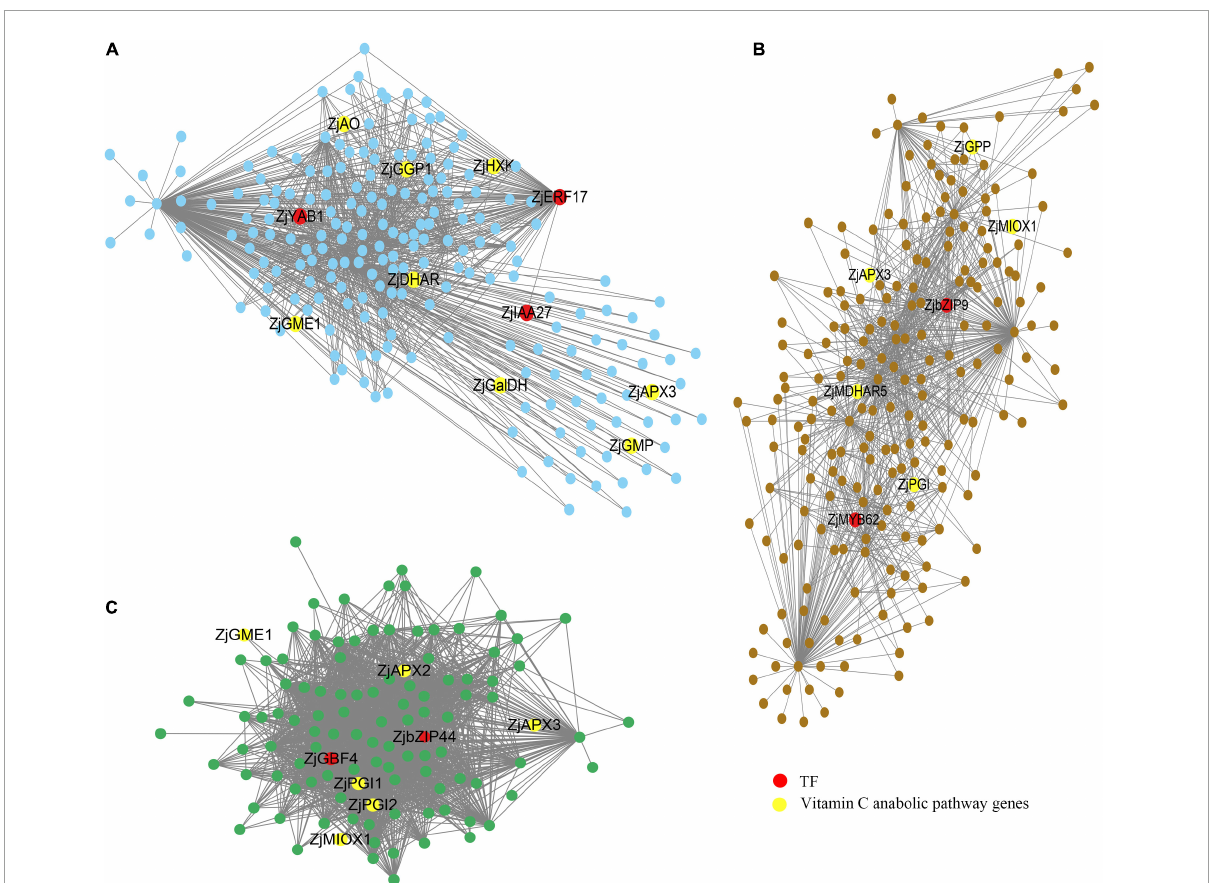
FIGURE6 Gene networks involved in AsA regulation during jujube fruit development. (A) Gene network for the MEtan module. (B) Gene network for the MEbrown module. (C) Gene network for the MEgreenyellow module.